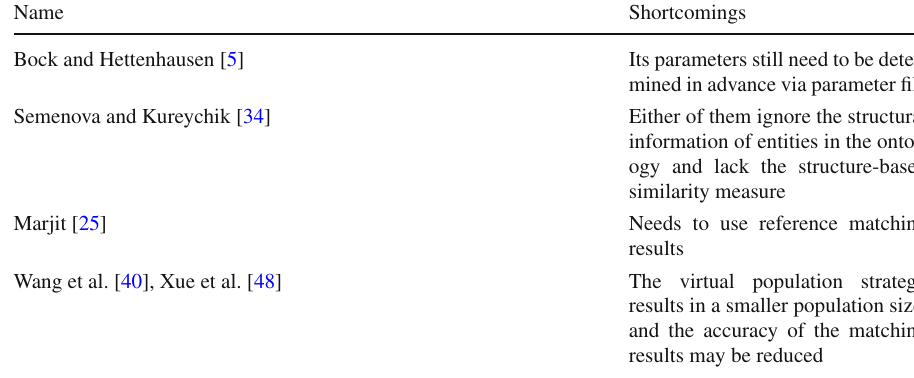
Table 2 PSO-based ontology matching technologies and their